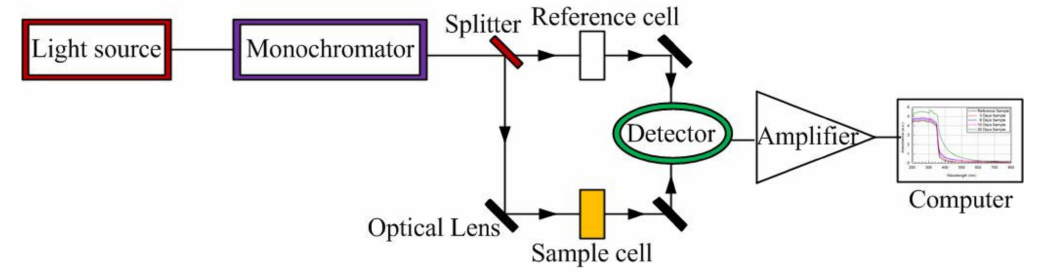
Figure 3. Schematic diagram for the experimental setup of UV-Vis spectroscopy. Transformer oil is composed of hydrocarbon compounds, including highly conjugated compounds. When a sample of transformer oil is tested using a UV-Vis spectrophotometer, it absorbs light at specific wavelengths. When the transformer oil ages, aging byproducts are generated, and the sample becomes darker. Therefore, the light transmitted through the sample is decreased. The absorbance spectra of different durations for aged oil samples were measured and